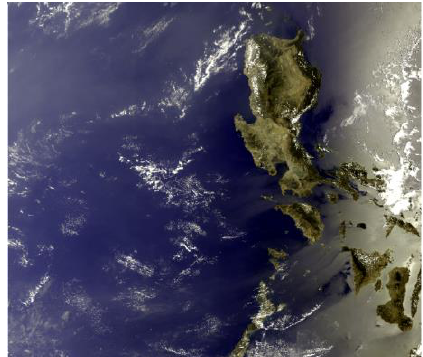
Figure 4. Radiometrically-calibrated Sentinel-3 OLCI true color image of Metro Manila acquired on 25 April